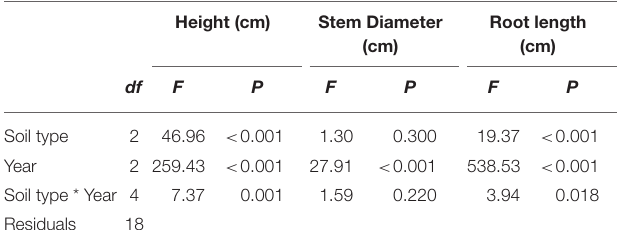
TABLE 1 | Results from analysis of variance (ANOVA) for plant height, stem diameter and root length.